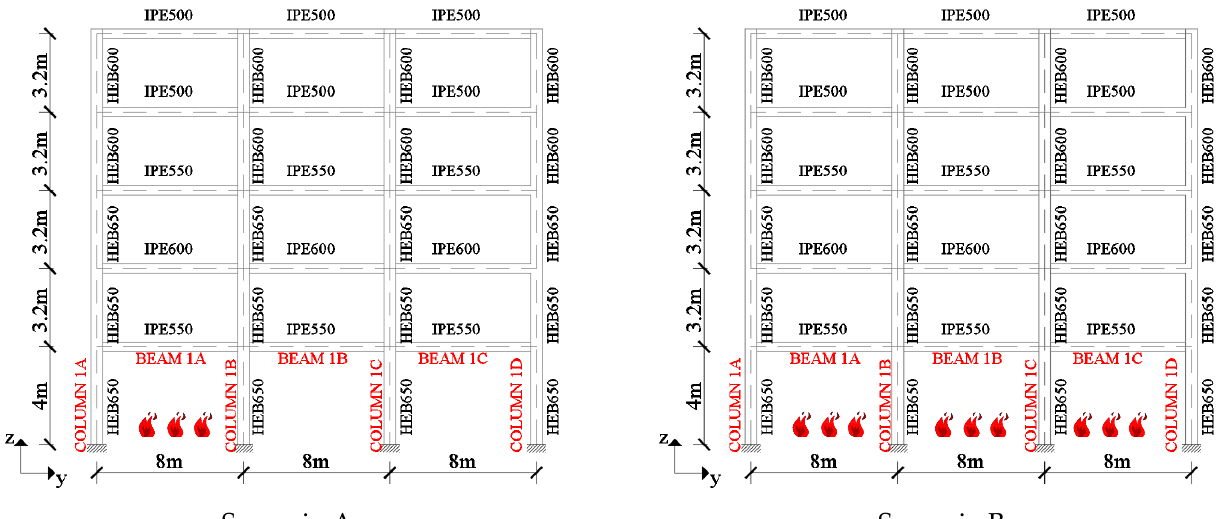
Figure 18. The seismic resistant frame and the fire scenarios.